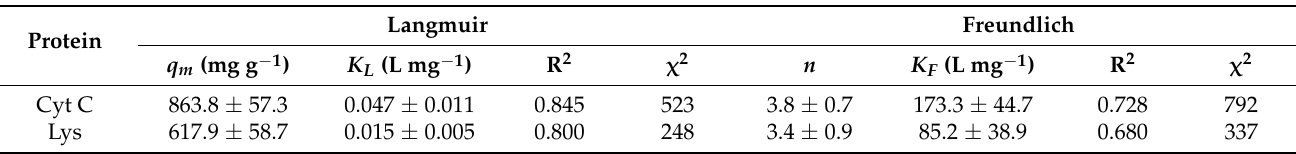
Table 2. Adsorption isotherms